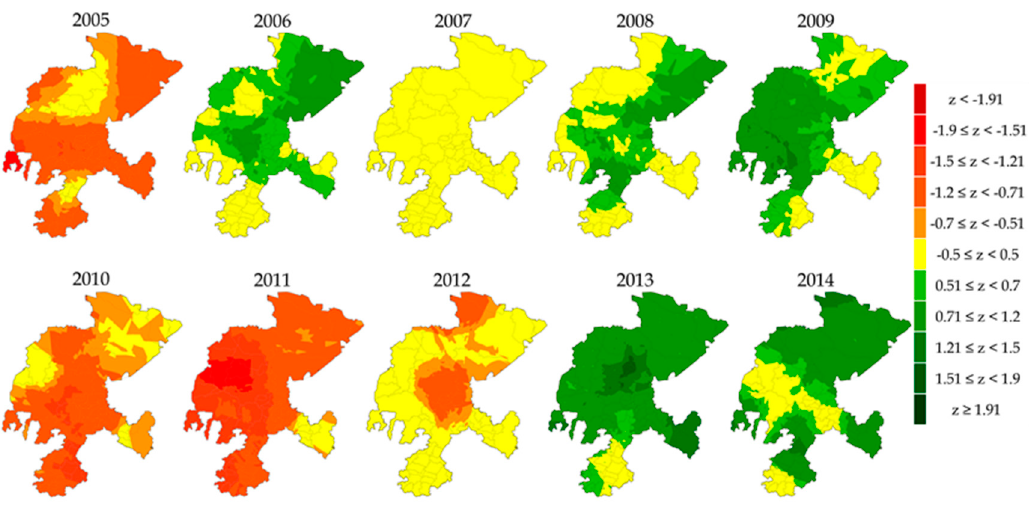
Figure A6. Twelve ‐ month timescale Reconnaissance Drought Index (April–March). Figure A6. Twelve-month timescale Reconnaissance Drought Index